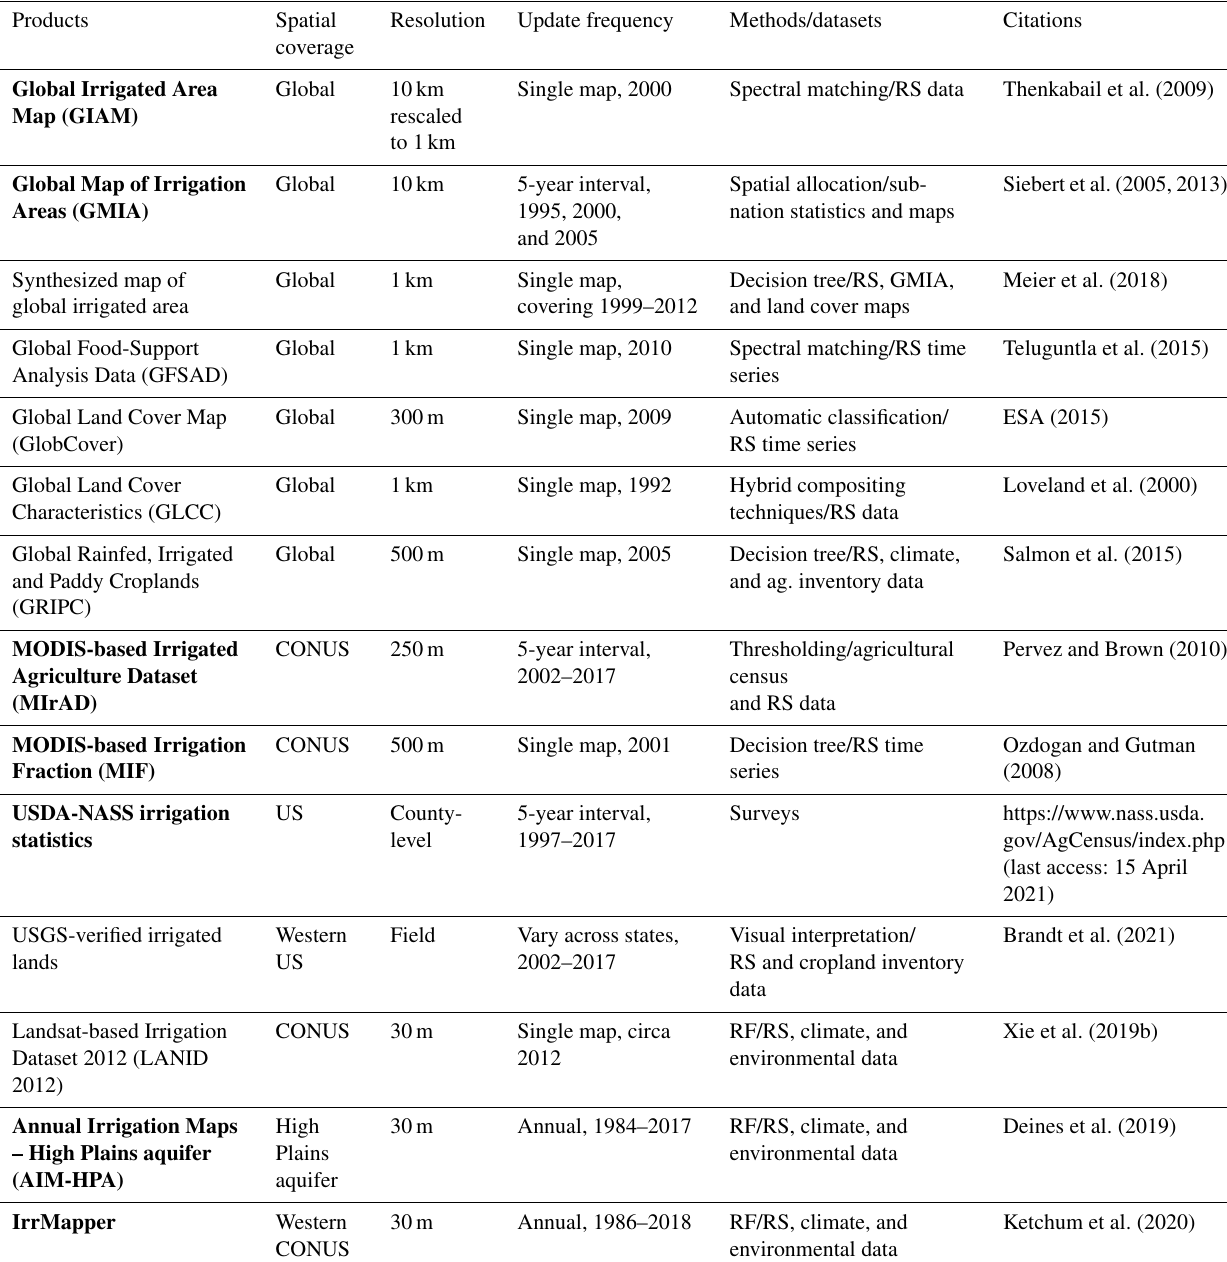
Table 1. Currently available irrigation maps covering part to the entire CONUS. The boldfaced maps are compared with LANID in the Results section (RF: random forest; RS: remote